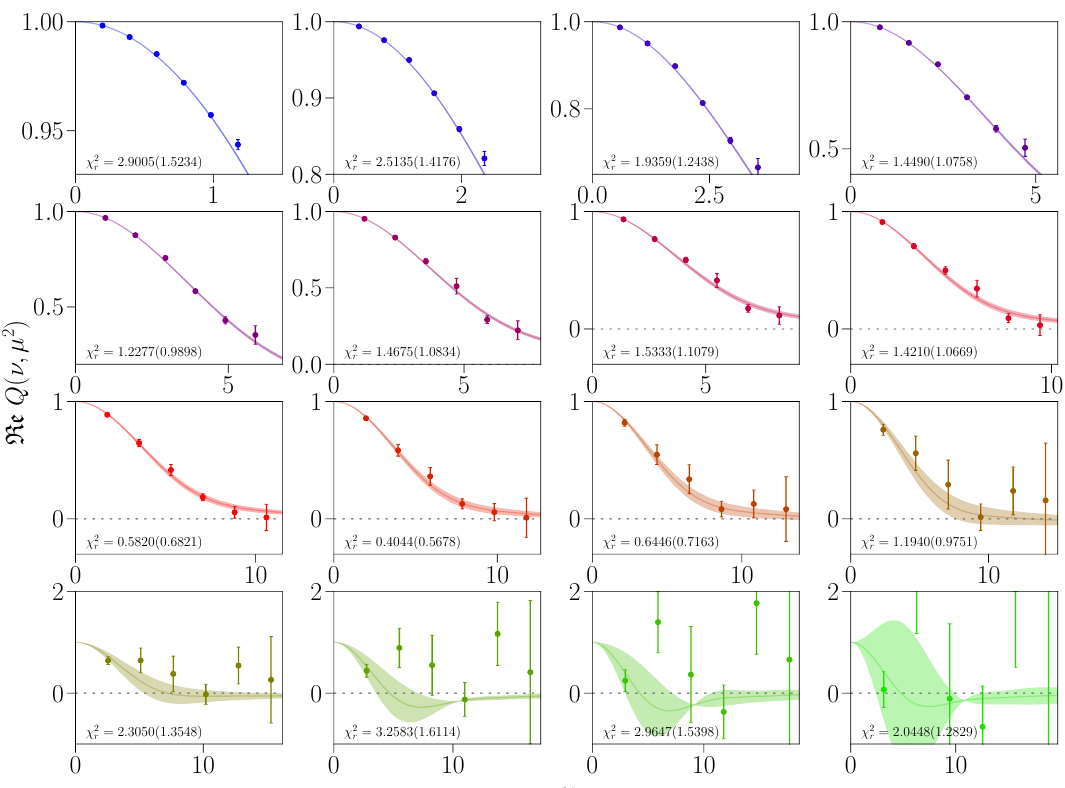
Figure 22. Cosine transform of the two-parameter model PDF, with the same functional form as (5.1), fit separately to each z 2 of the matched ITD. The ITD was obtained using (5.3) for the evolution/matching step. Data correlations have been included in each fit. Starting from the upper left panel and traversing horizontally, z/a increases from unity. The correlated figure of merit for each separate fit is also